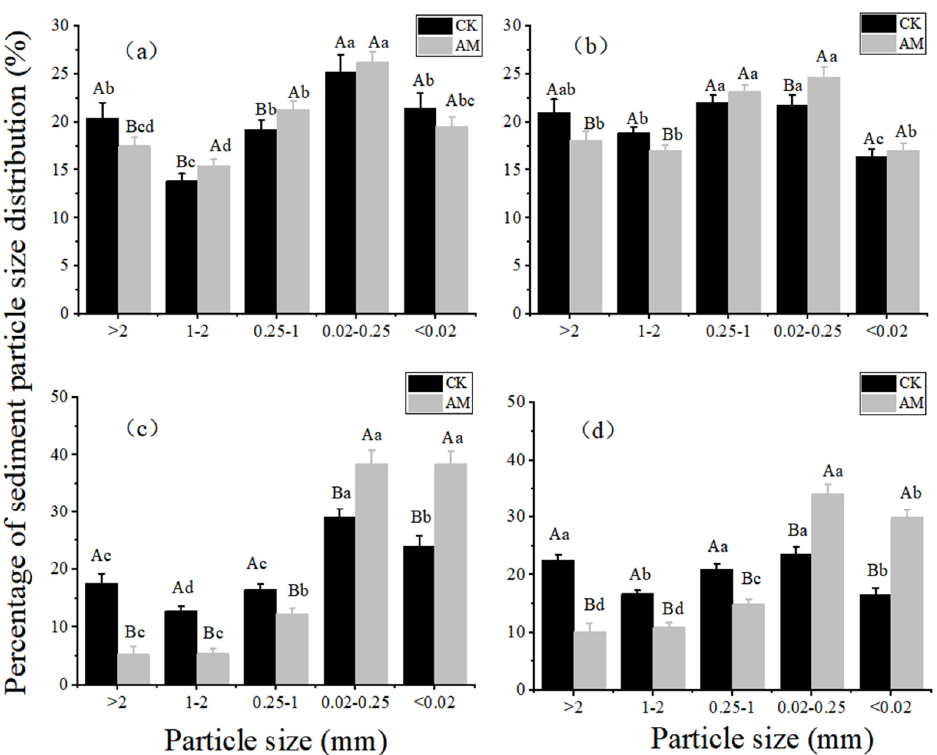
Figure 5. Sediment particle size distribution in different soil troughs under simulated scouring in ( a ) Cynodon dactylon , ( b ) Lotus corniculatus , ( c ) Zoysia japonica , and ( d ) Astragalus sinicus . Different capital letters indicate significant differences in the same particle size between different treatments ( p < 0.05), and different lowercase letters indicate significant differences between different particle sizes in the same treatment ( p < 0.05). Error bars represent ± standard errors.